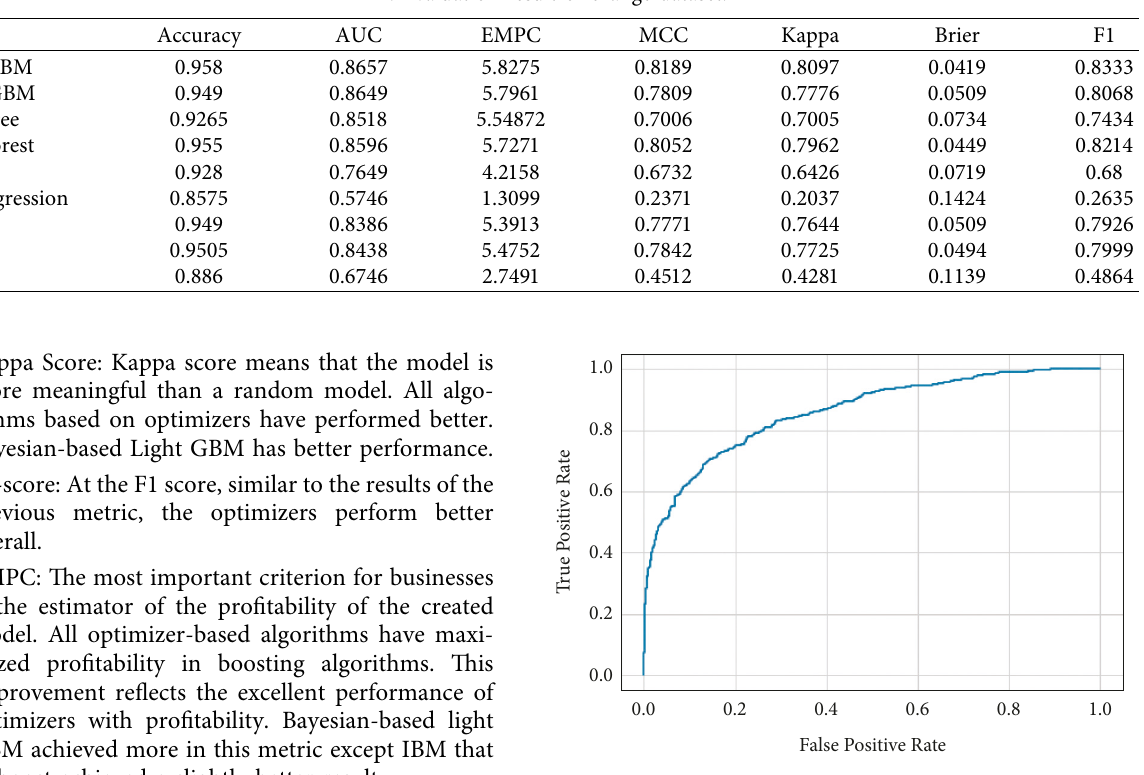
Figure 6: ROC curve